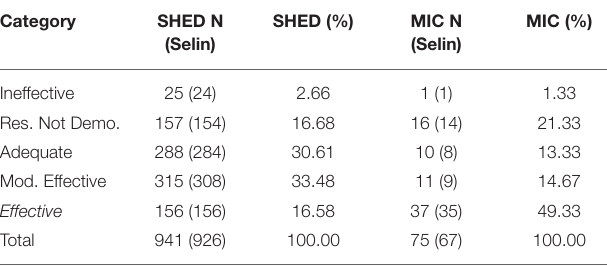
TABLE 1 | Performance levels for two organizational